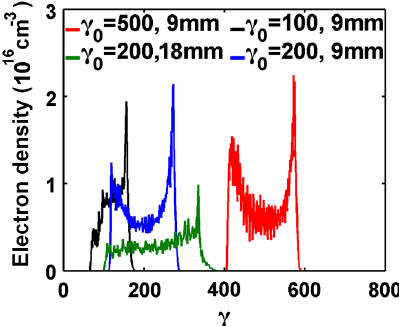
FIG. 7. Energy spectra of beam electrons for different initial energies: (cid:1) 0 ¼ 100 , 200, and 500 after 9 mm of acceleration, are the red line, black line, and blue line, respectively, while the green line is (cid:1) 0 ¼ 200 after 18 mm acceleration. In all cases the normalized vector potential was a 0 ¼ 0 : 1 .